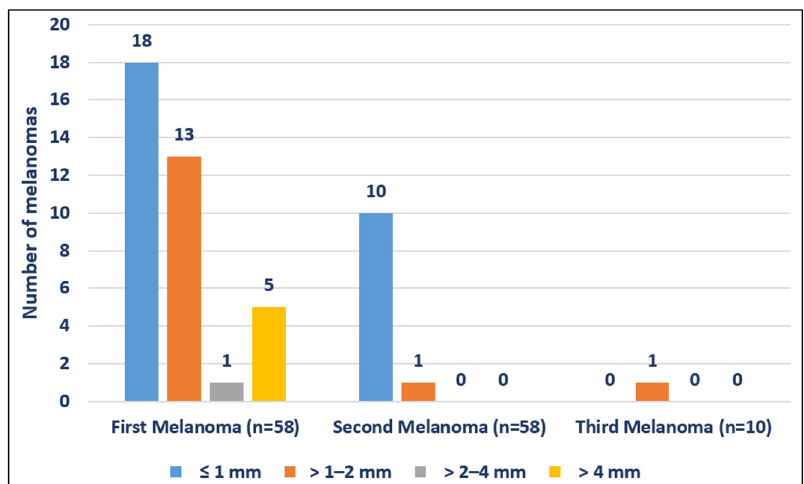
Breslow thickness of 1.4 mm.